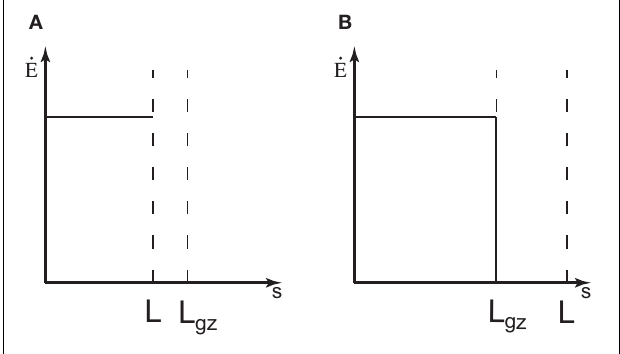
FIGURE 3 | The elongation rate of an organ. (A) When the organ is shorter than the length of the growth zone, L < L gz , it is expected that the whole organ is elongating. For simplicity, it is considered that the elongation rate is constant along the organ ˙ E 0 . (B) If the length of the organ is longer than the elongation zone, L > L gz , the elongation rate is equal to 0 outside the growth